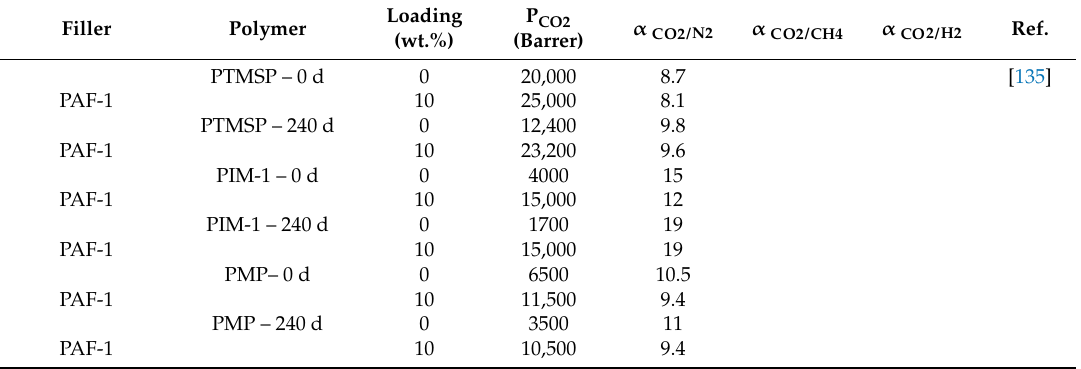
Table 6. Gas separation performance of porous organic frameworks (POFs)-based mixed